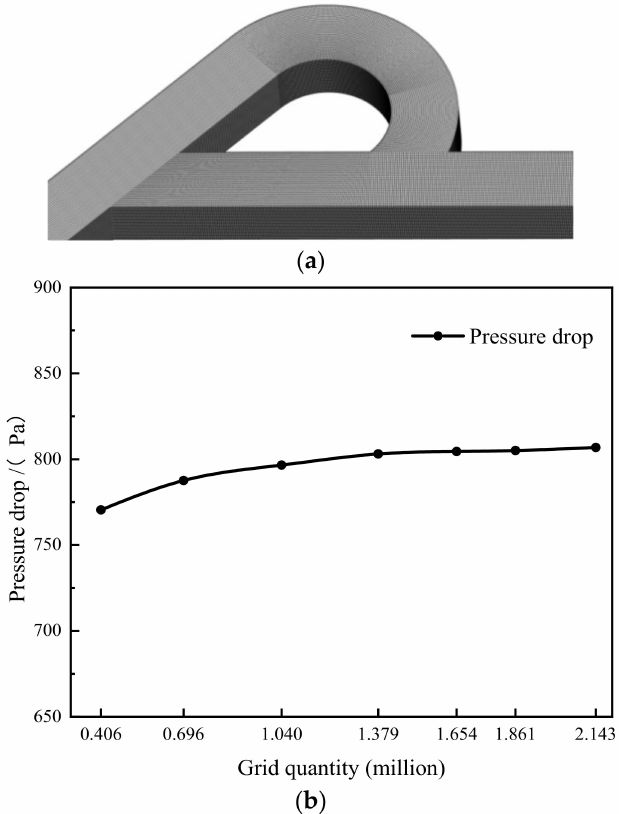
Figure 2. Computational mesh and grid-independence study. ( a ) Mesh for the single stage Tesla-type channel. ( b ) Pressure reduction between inlet and outlet under different grid densities.